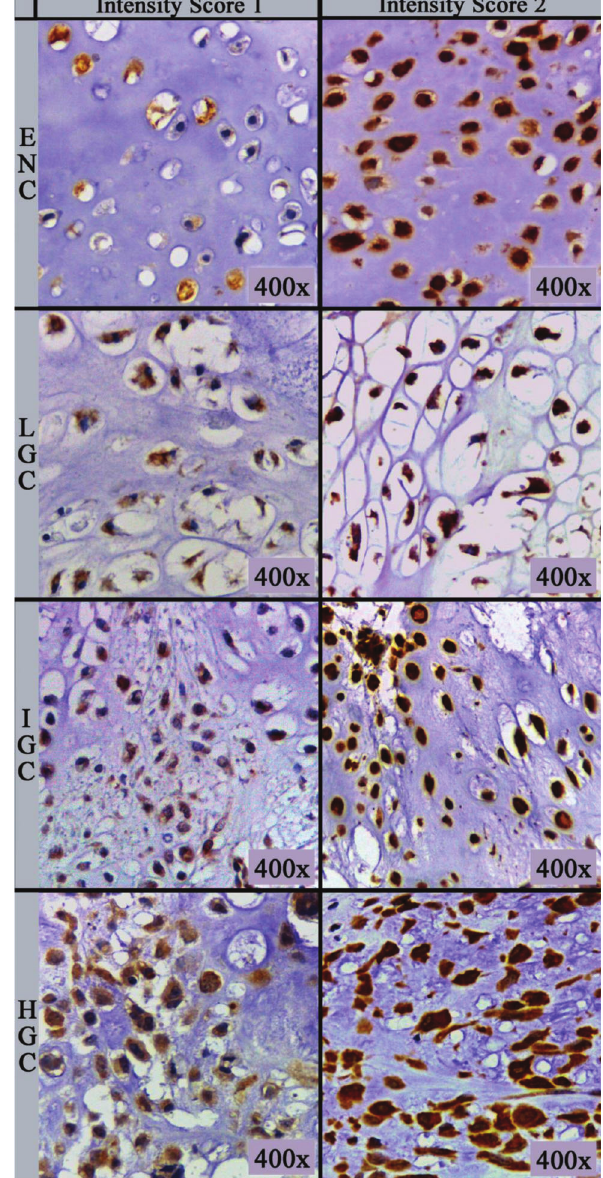
Figure 1 - Intensity score by diagnostic group. Antibody: Amphir- egulin (original magnification, 400 (cid:1) ). ENC, enchondroma; LGC, low-grade chondrosarcoma; IGC, intermediate-grade chondrosar- coma; HGC, high-grade